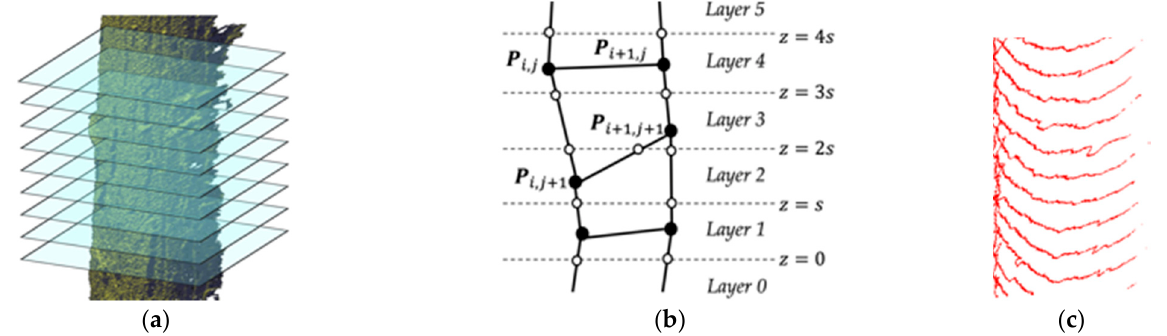
Figure 8. Section points between a wireframe model and horizontal planes. ( a ) Horizontal planes; ( b ) intersections (white circle); ( c ) section points.